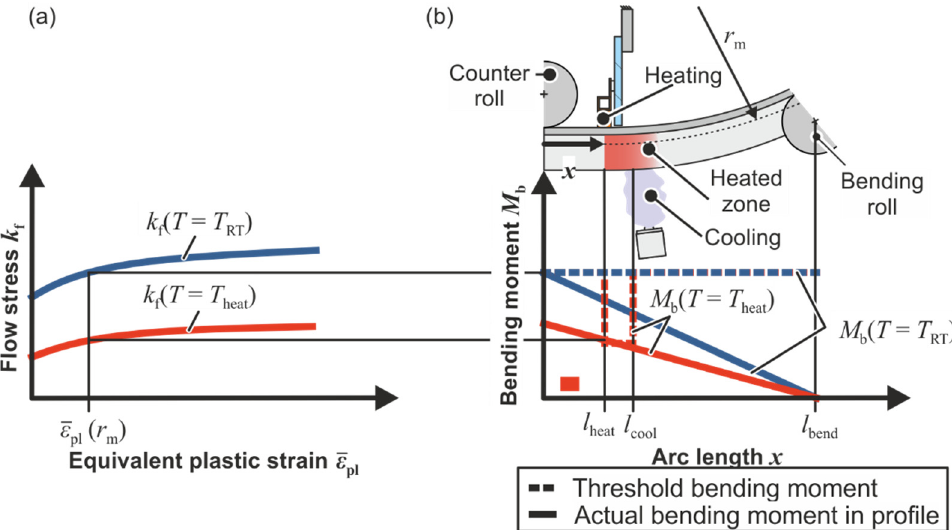
Figure 4. ( a ) Resulting flow stress k f to bend a profile to the desired radius r m , ( b ) necessary bending moment to reach the desired radius and actual profile bending moment for room temperature ( M b ( T RT )) and partial heated case ( M b ( T h )).